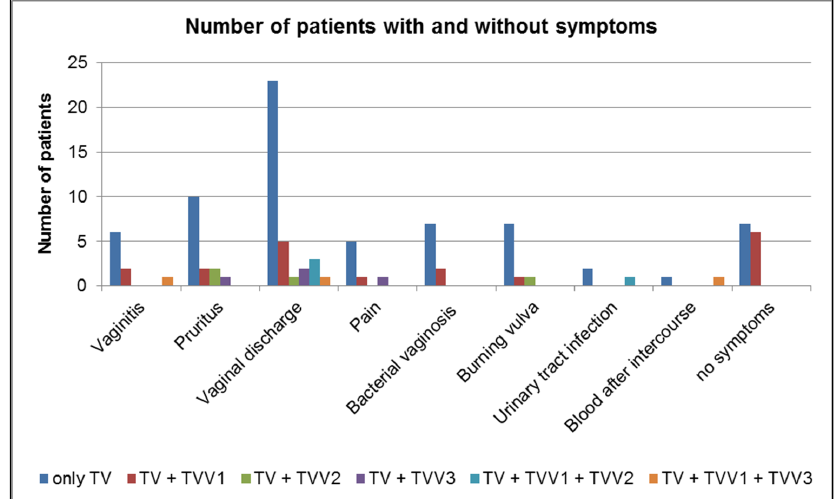
Figure 1. Numbers of TV infected patients without (no symptoms) or with symptoms (vaginitis, pruritus, vaginal discharge, pain, bacterial vaginosis, burning vulva, urinary tract infection, blood after intercourse) in correlation with TVV presence (TV + TVV1, TV + TVV2, TV + TVV3, TV + TVV1 + TVV2, TV + TVV1 + TVV3) or absence (only TV). 2.4. Detection of M. hominis in TV and Vaginal/Urethral Swabs M. hominis was detected in vaginal/urethral swabs (culture method: colonies on an agar plate in the Outpatients Centre) in 30 of the 82 TV-positive patients (37%) (27 female, 3 male); M. hominis DNA was proven in 23 of the 82 cultured TV isolates by PCR (28%) (Table 2). In 12 patients (12/82; 15%), with M. hominis detected by culture in the Outpatients Centre, M. hominis DNA was also detected inside TV. In 18 patients (18/82; 22%), M. hominis was detected only by culture, not inside TV by PCR. In 11 cultured TV isolates (11/82; 13%) M. hominis was only detected by PCR (Table 2). Table 2. Detection of M. hominis in patients with TV infection and within TV isolates. Number of Positive Patients and Cultured TV Isolates 82 M. hominis in patients (culture) M. hominis in patients and in TV (culture and PCR) M. hominis only in patients (culture), not in TV 17/72 (24%) 1/10 (10%) M. hominis only in TV (PCR), not in patients (culture) 10/72 (14%) 1/10 (10%) 2.5. Prevalence of M. hominis in Symptomatic and Asymptomatic Patients culture method, 4 patients (2 female, 2 male) did not report any symptoms (13%).